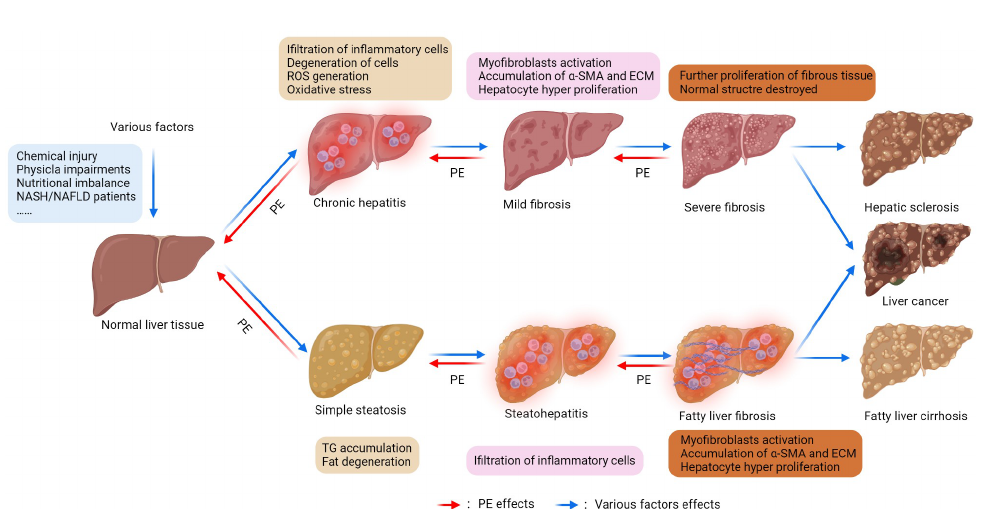
Figure 1. The development of the normal liver toward cirrhosis or liver cancer (figure was created using BioRender (Biorender, Toronto, Canada)). Chemical drugs, physical damage, and nutritional disorders can cause the normal liver to develop cirrhosis or liver cancer via two major pathways. (1) The factors above may induce inflammatory cell infiltration, hepatocyte degeneration, reactive oxygen species (ROS) production, and oxidative stress (OS) in the liver, further activating hepatic stellate cells (HSC) and transforming them into myofibroblasts (MFBs). The activated HSC and MFBs express high alpha-smooth muscle actin ( α -SMA) levels and secrete extracellular matrix (ECM), resulting in mild liver fibrosis. There is a gradual increase in fibrous tissue and pseudolobule, and